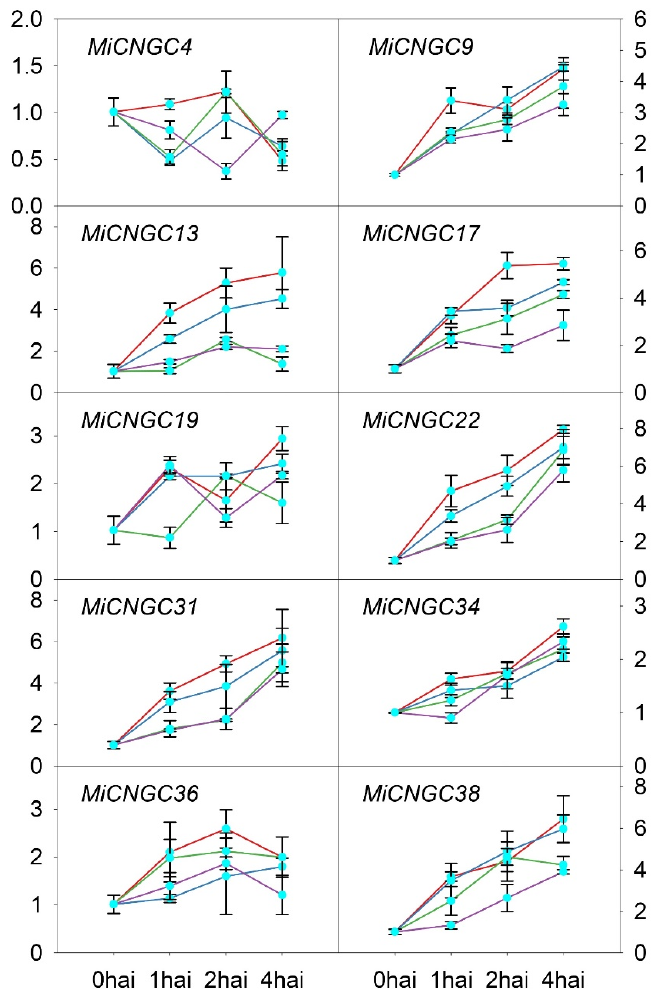
Figure 5. The expression of CNGC genes under cold stress of 2 (red), 4 (blue), 6 (green) and 8 °C (purple) in mango leaf according to qRT ‐ PCR. The x ‐ axis represents the samples collected at 0, 1, 2 and 4 h after incubation (hai) at different temperatures. The y ‐ axis represents the values of 2 −ΔΔ Ct . The error bar represents the standard error.